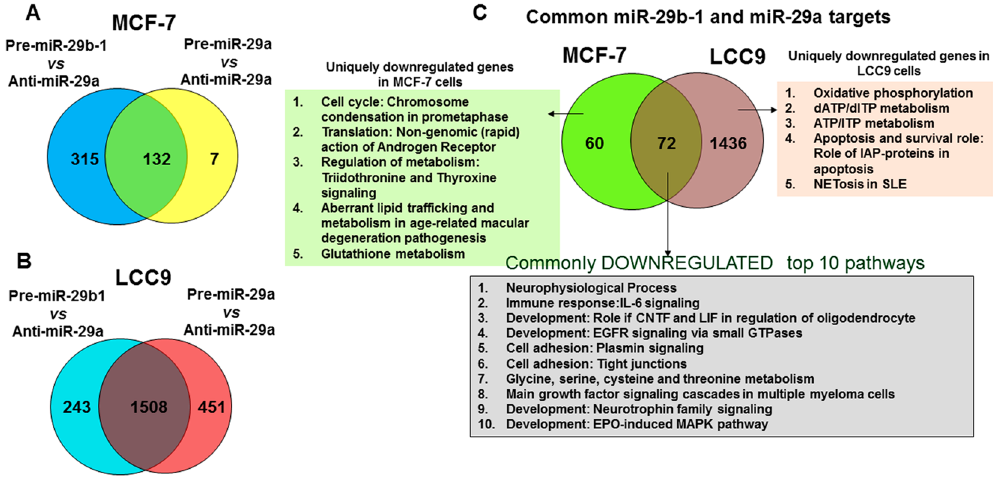
Figure 1. Enrichment analysis of RNA-seq data. Differentially expressed genes were identified in pairwise comparisons: Pre-miR-29b-1 vs . Anti-miR-29a and Anti-miR-29a vs. Pre-miR-29a using tophat and cufflink- cuff diff2. The Venn diagrams show the number of differentially and commonly regulated genes identified. GeneGo Pathways Software (MetaCore TM ) was then used to identify genes significantly downregulated by miR- 29b-1 and miR-29a in ( A ) MCF-7 and ( B ) LCC9 cells. ( C ) Pathway analysis of the downregulated genes was performed using MetaCore TM . The order of the pathways identified for each comparison are listed in the order provided by MetaCore TM